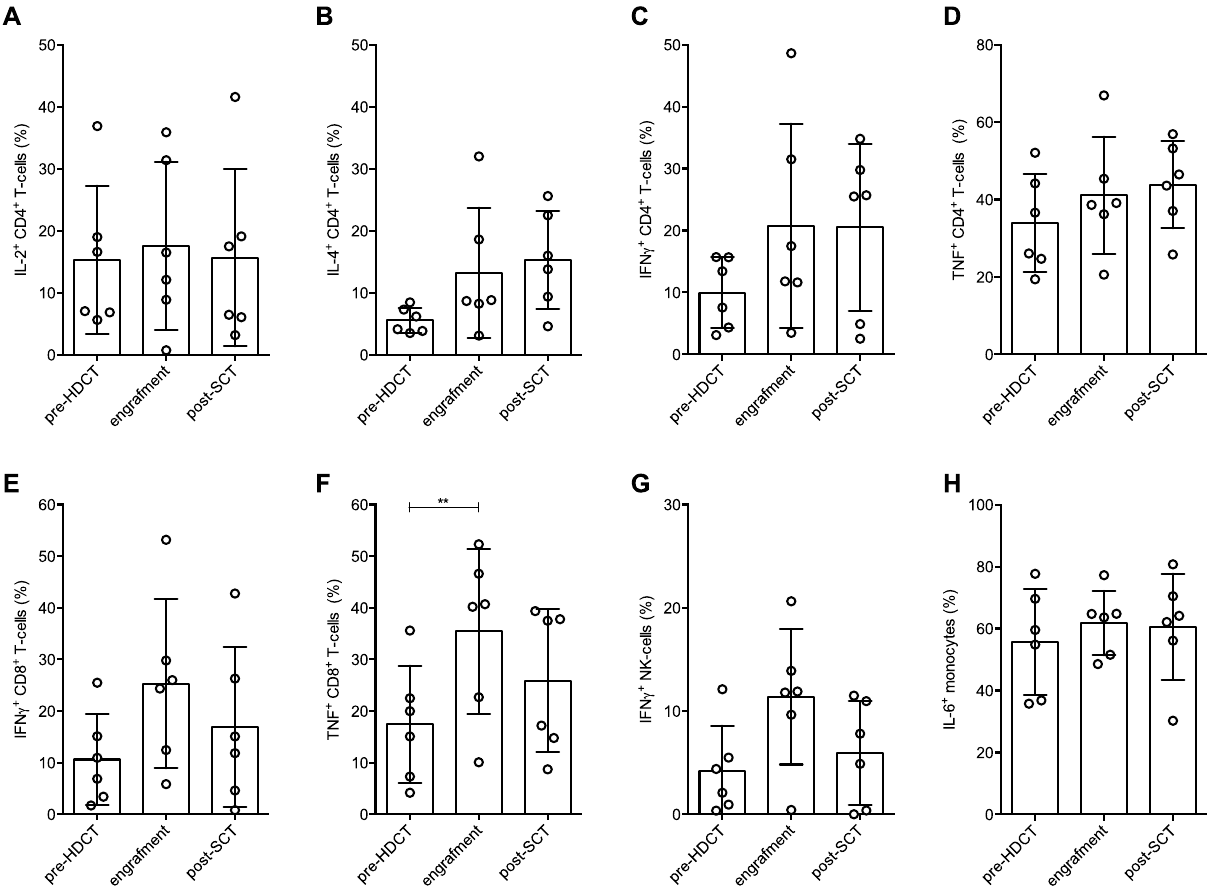
Figure 2. T-cells, NK-cells, and monocytes maintain their ability to produce cytokines following HDCT/auto- SCT. ( A – D ) Illustration of the percentages of IL-2 ( A ), IL-4 ( B ), IFN-γ ( C ) and TNF ( D ) positive CD4 + T-cells during HDCT/ auto-SCT upon stimulation with Phorbol-12-myristat-13-acetat (PMA)/ Ionomycin. ( E–G ) Plotted are the percentages of IFN-γ ( E ) and TNF ( F ) positive CD8 + T-cells as well as of IFN-γ positive NK-cells ( G ) at the indicated time points. ( H ) Percentage of IL-6 positive monocytes upon LPS stimulation (n: 6, mean values +/− SD). Statistical significance was determined using a Friedman test with Dunn’s multiple comparison tests for repeated measurements. **P <